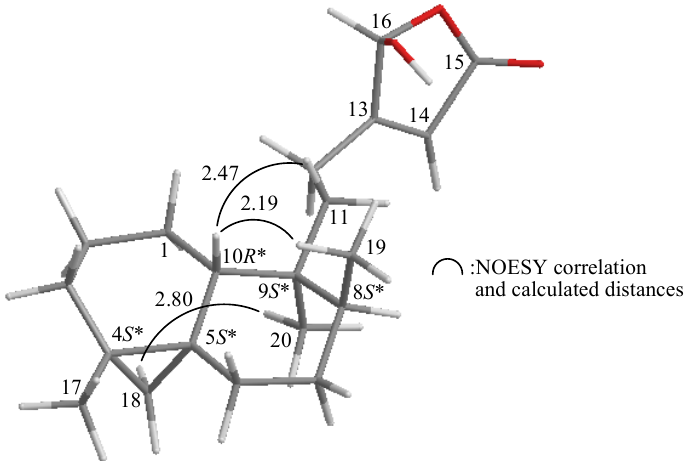
Figure 3. The computer-generated model of 1 using MM2 force field calculations and the calculated distances (Å) between selected protons with key NOESY